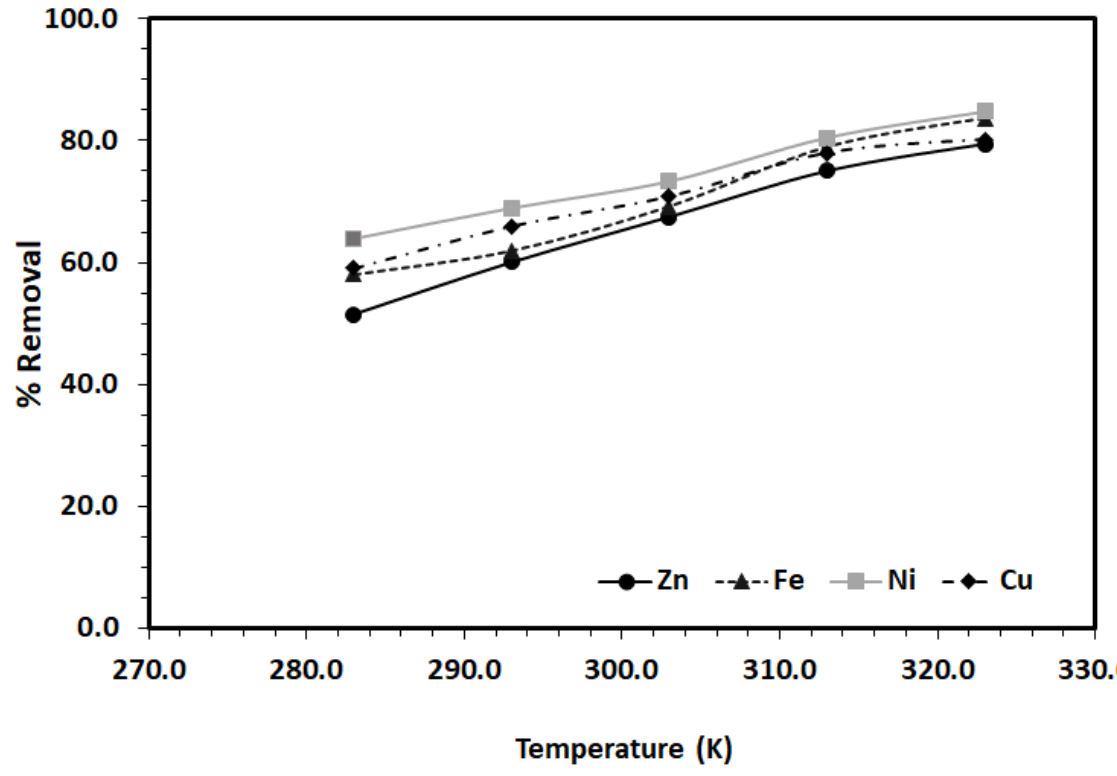
Figure 9. Effect of solution temperature on the removal of metal ions (Zn, Fe, Ni, Cu) adsorption from a desalination plant outfall brine discharge by HS nanoclay. (Experimental conditions: 60.0 mL solution, 90 min adsorption time, 150 mg dosage, and pH 8.0).